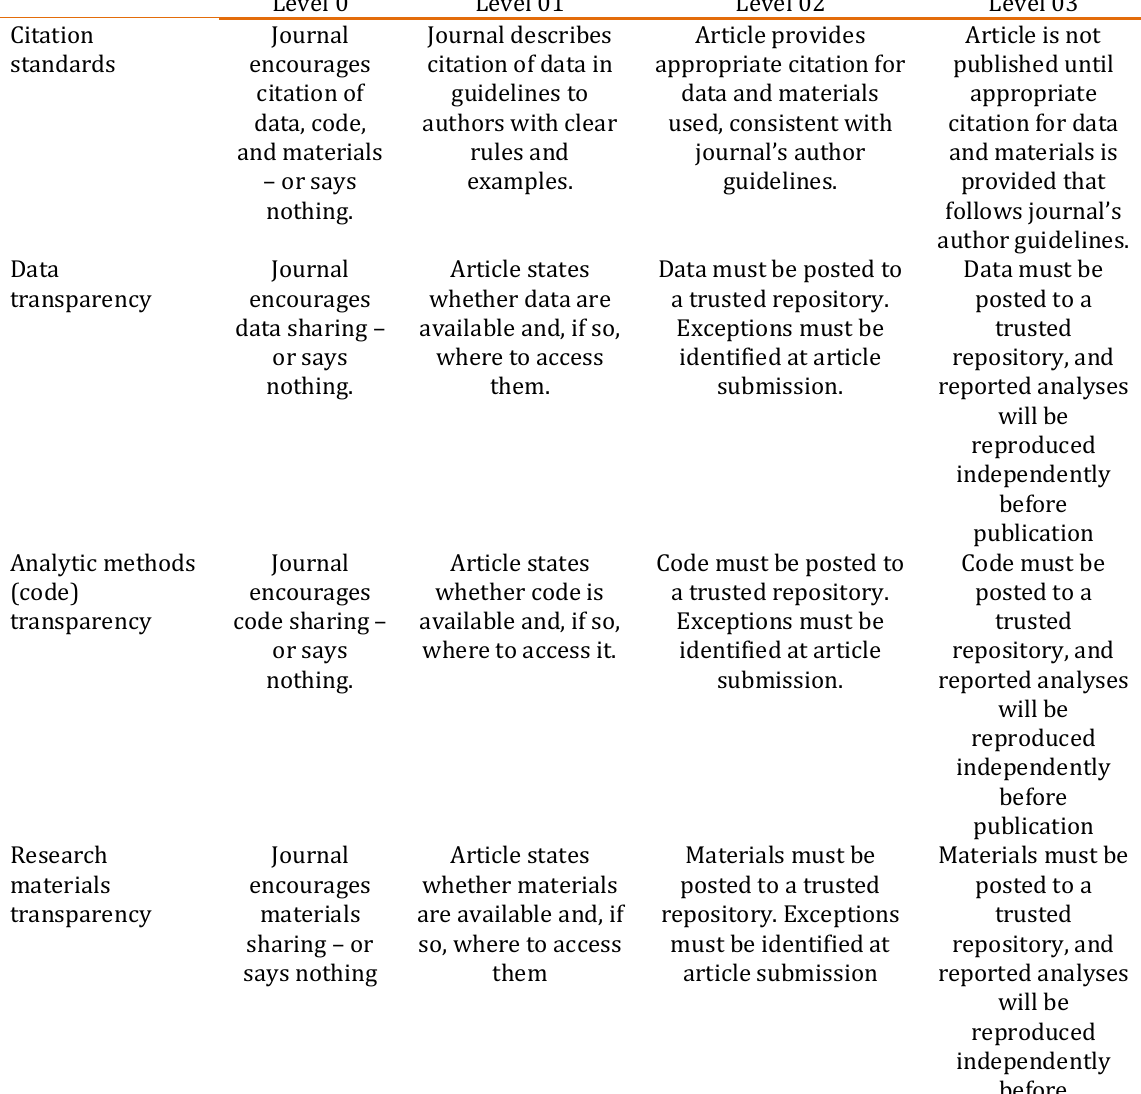
Table 02. Summary of the eight standards and three levels of the TOP